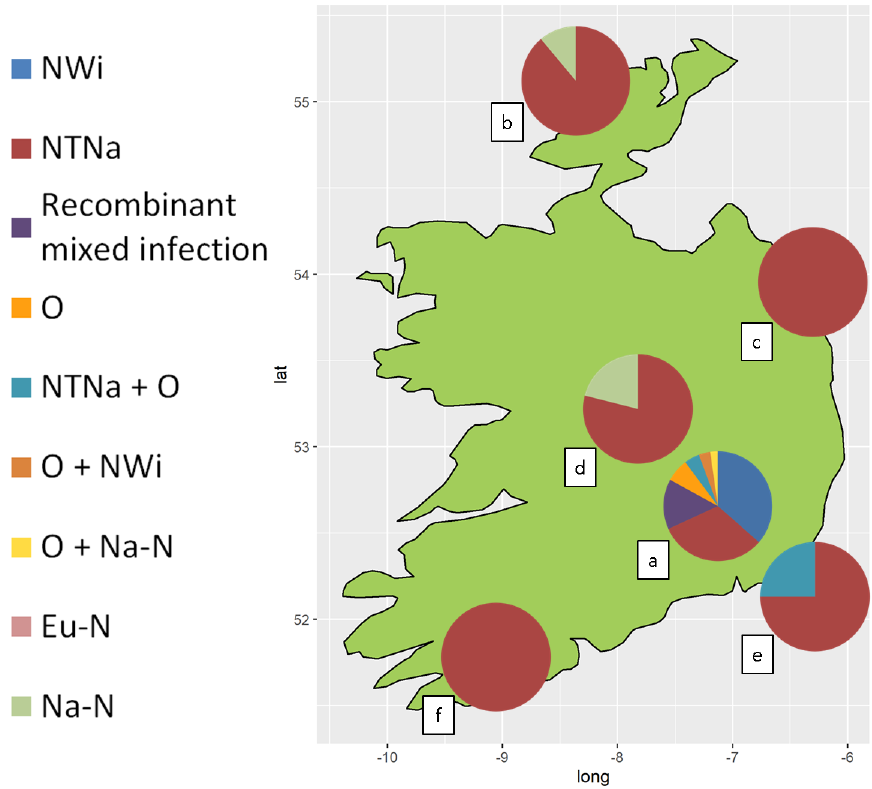
Figure 1. Relative incidence of PVY genotypes in di ff erent counties of the Republic of Ireland. (a) Diverse collection of potato germplasm Co. Carlow and Kilkenny ( n = 88). Seed tuber potato crops in (b) Co. Donegal ( n = 9); (c) Co. Louth ( n = 34); (d) Co. O ff aly ( n = 19); (e) Co. Wexford ( n = 8); (f) County Cork ( n =